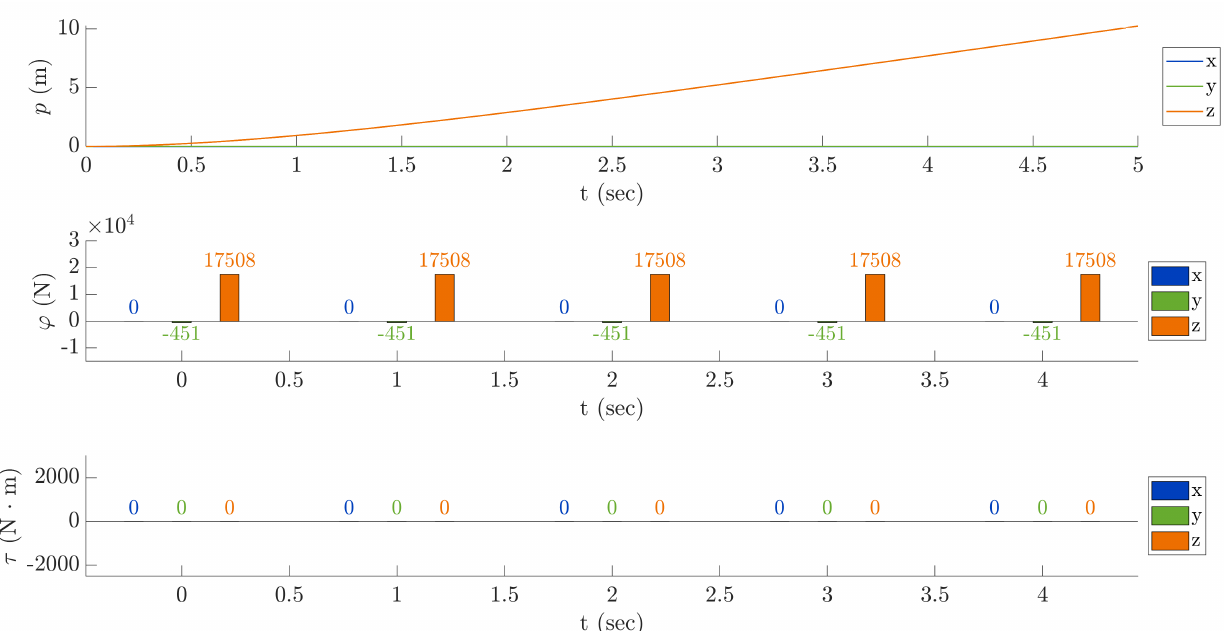
Figure 13. Third test—neither yaw nor drift.